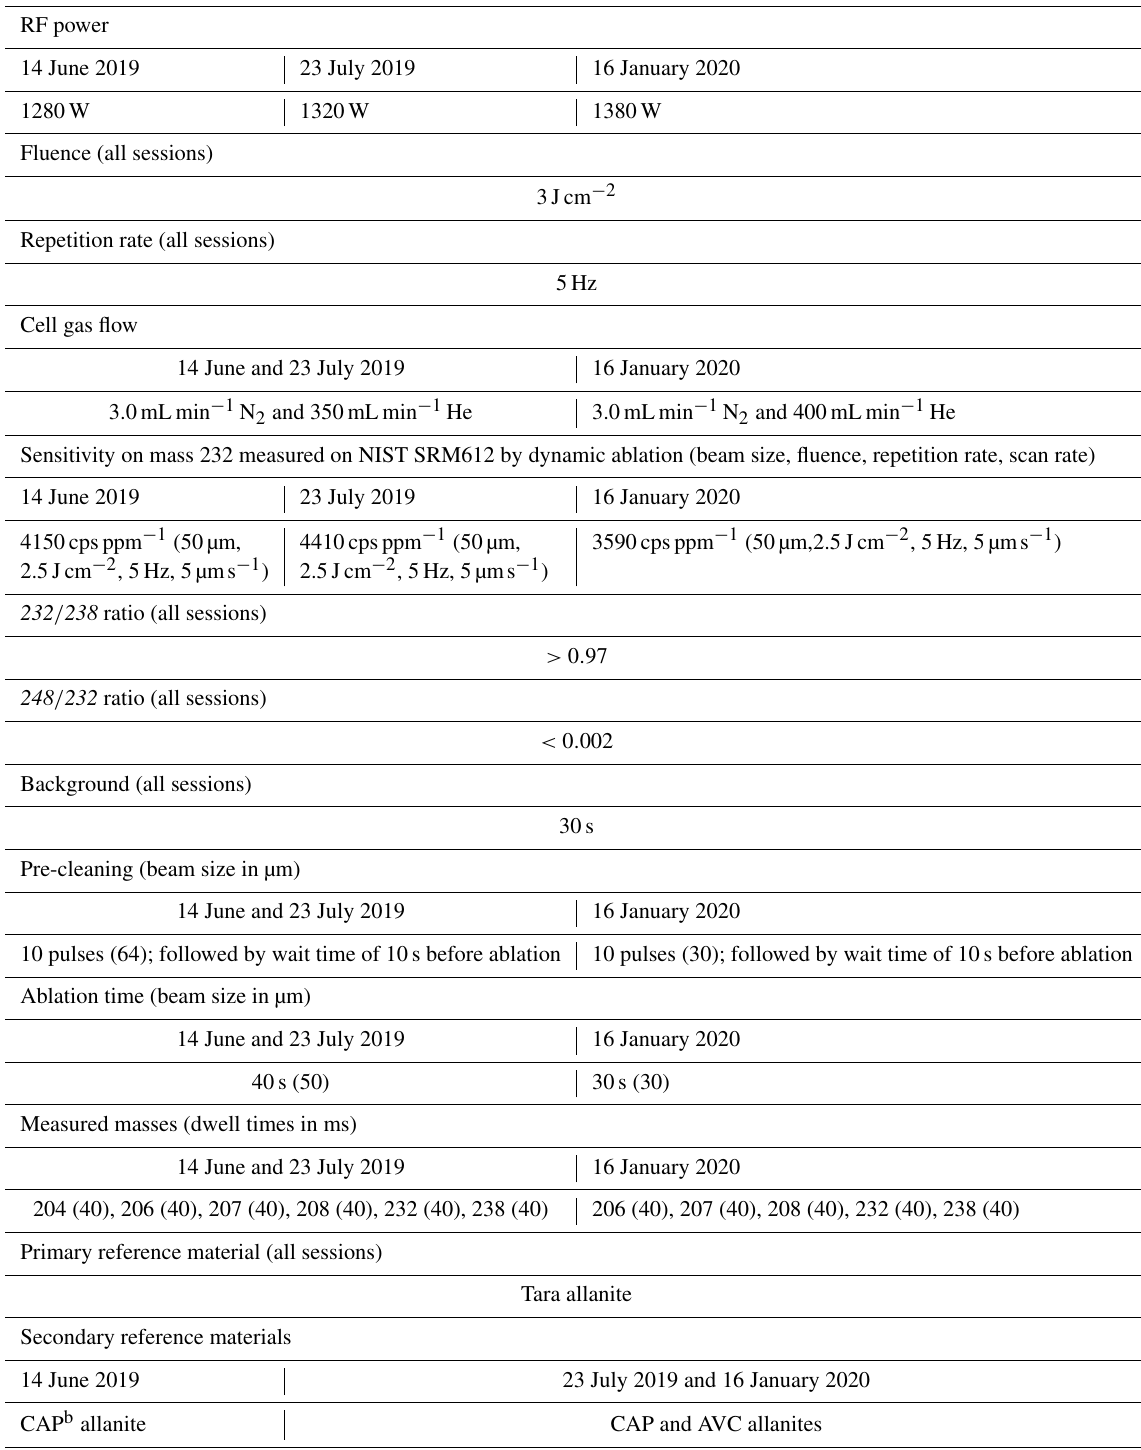
Table 1. Measurement conditions of the Agilent 7900 for U − Th − Pb isotopic data by LA-ICP-MS. RF